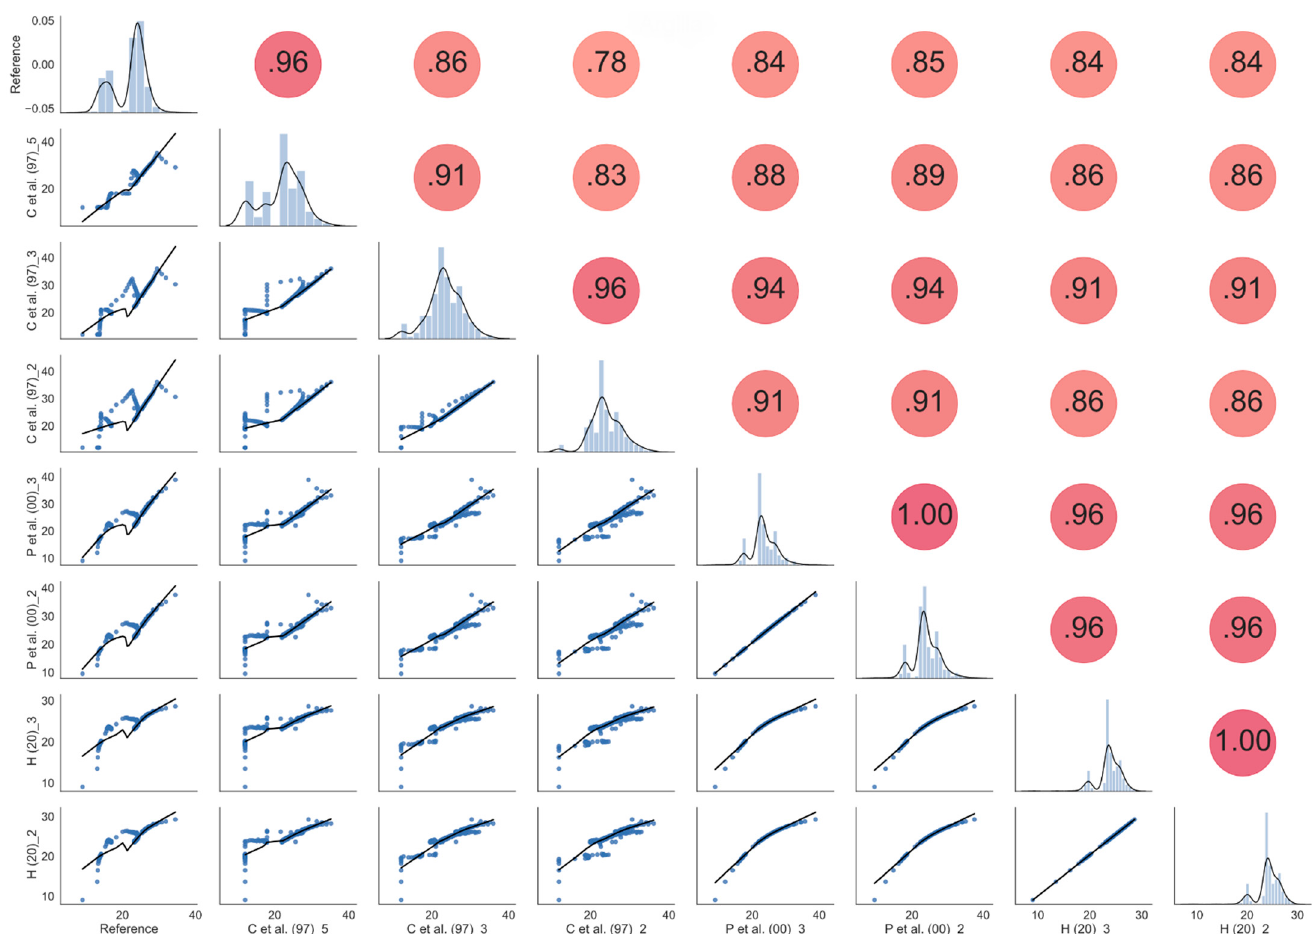
Figure 20. Statistical analysis with scattering plots, cross-correlation values, and kernel density estimation (KDE) obtained by using the Seaborn Python3 tool [73–75] in Silty Loam.